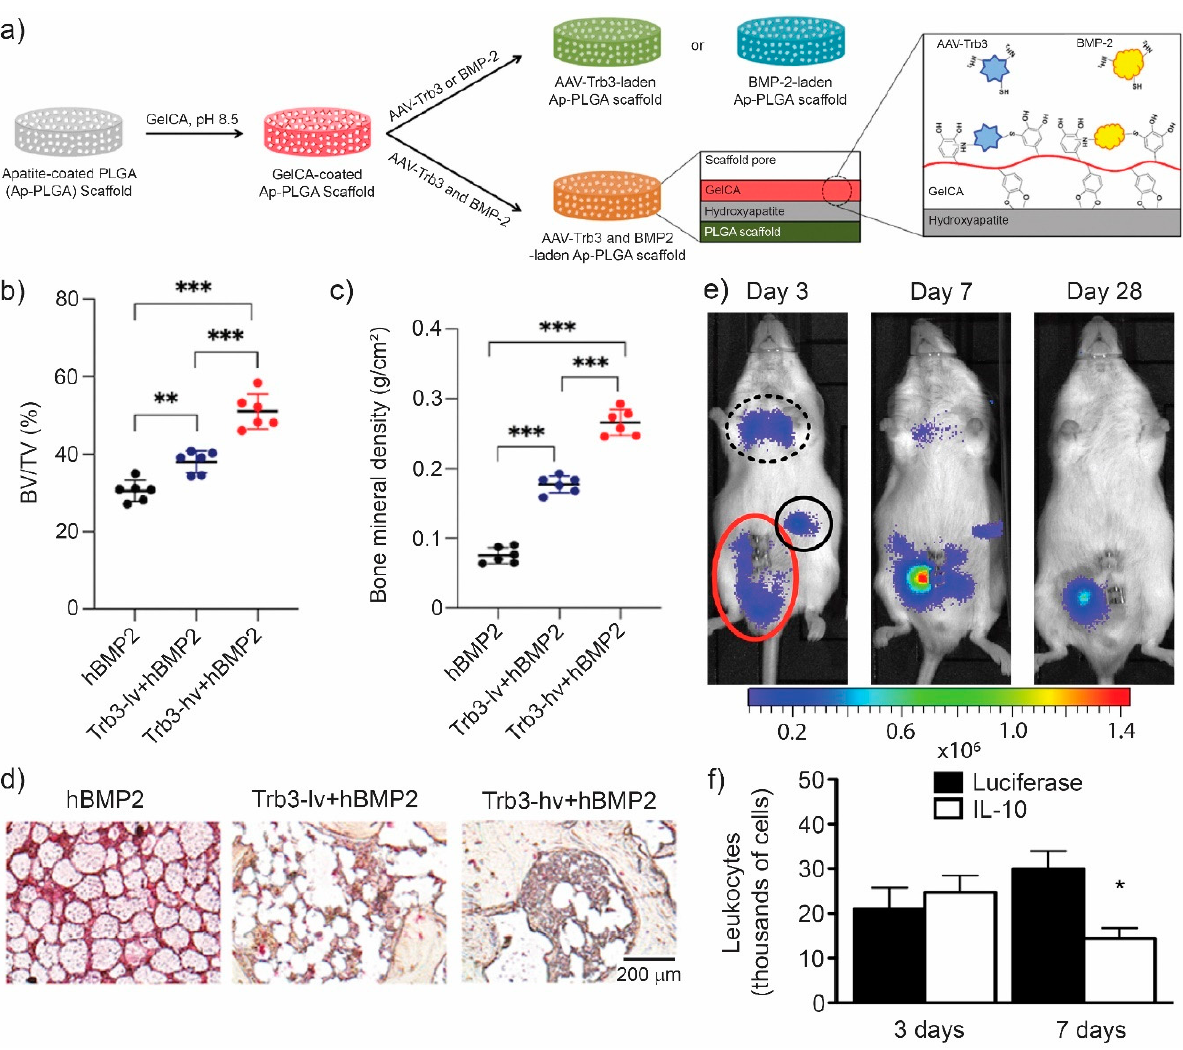
Figure 5. Synergistic approaches combining multifunctional scaffolds with gene or immune therapy for TERM. ( a ) Schematic diagram of scaffold fabrication through coating gelatin-conjugated caffeic acid (GelCA) onto the surface of apatite- PLGA (Ap-PLGA) scaffold. The GelCA-coated hybrid biopolymer scaffold was adopted to deliver adeno-associated vi- ruses-encoding Trb3 or/and recombinant BMP-2 protein. ( b – d ) Promotion of bone formation ( b , c ) and fat-filled cyst for- mation inhibition in rat critical-sized mandibular defects 12 weeks after scaffold implantation loaded with high dose BMP- 2 (hBMP2) and/or low and high dose adeno-associated viruses-encoding Trb3 (Trb3-lv and Trb3-hv, respectively). ( b ) Bone volume/tissue volume percentage. ( c ) Bone mineral density. Values represent mean ± SD: ** p < 0.01 and *** p < 0.001 using one-way ANOVA test. ( d ) Oil red immunohistochemical stain showing fewer adipocyte-like cells in area of defects treated with high dose AAV-Trb3 and BMP-2 than with BMP-2 alone. ( e ) Transgene expression in vivo. Representative biolumi- nescence images at days 3, 7, and 28 postimplantation of scaffolds loaded with luciferase lentivirus and implanted into the right intraperitoneal fat pad. Color bar indicates radiance (p/sec/cm 2 /sr). ( f ) Leukocyte infiltration into IL-10 virus releasing scaffolds. Number of CD45 positive cells isolated from scaffolds loaded with IL-10 or luciferase virus at day 3 and day 7 post implantation. * p < 0.05 versus day 7 luciferase. ( a – d ) adapted with permission from [164], Elsevier, 2020. ( e – f ) adapted with permission from [165], Elsevier, 2013. Angiogenesis is key in promoting functional healing and graft integration with the host tissue. Soft tissues such as skin are richly innervated and Schwann cells (SCs) play angiogenic roles that could assist wound healing. Laiva et al. fabricated gene-activated scaffolds to drive SCs differentiation and promote angiogenesis [166]. Freeze - dried po- rous Col - chondroitin sulfate scaffolds were fabricated and crosslinked to provide struc- tural reinforcement. Polyplex nanoparticles were formulated by mixing the cationic poly- mer vector polyethyleneimine (PEI) with plasmid DNA encoding stromal-derived factor- 1 α (SDF-1 α ), a proangiogenic chemokine gene. The polyplexes were soak loaded onto the freeze-dried scaffolds. SCs seeded on the scaffolds presented differentiation towards a